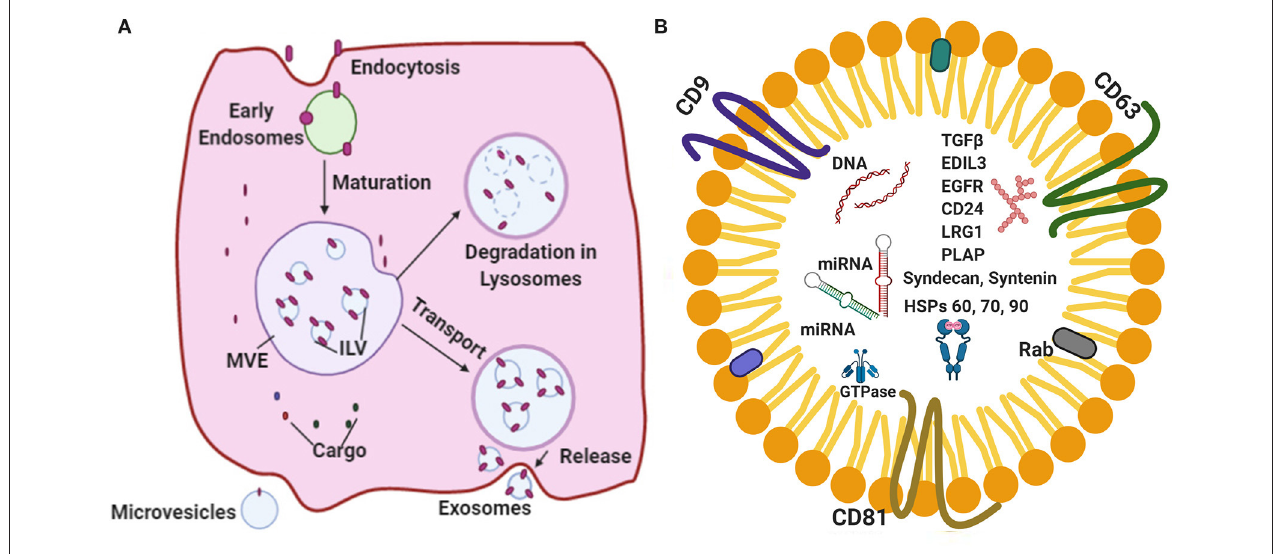
FIGURE 1 | (A) A schematic representation of the major vital components of the endosomal pathway synthesis and release. (B) Represents standard exosomal -markers that have been reported to serve as biomarkers for the identification of certain diseases. Exosomal cargo composed of various proteins, mRNA, miRNA and